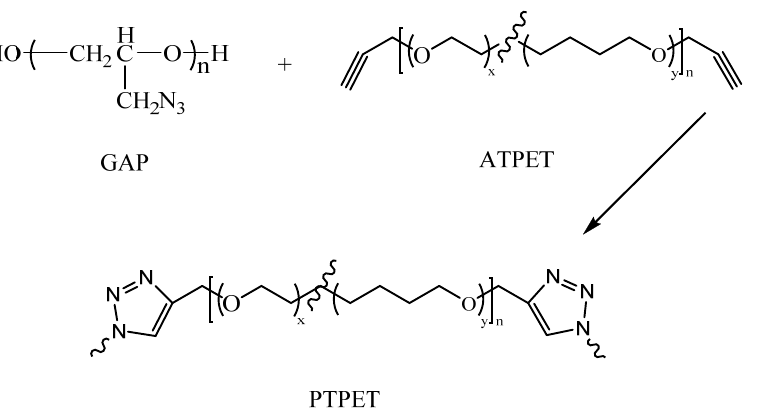
Figure 2. The click chemistry reaction between GAP and ATPET to synthesize PTPET.